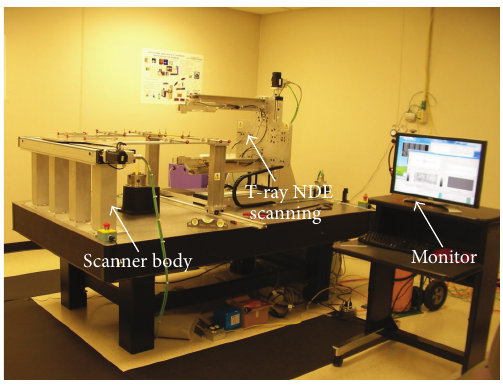
Figure 1: THz TDS system for imaging and material parameter measurement.